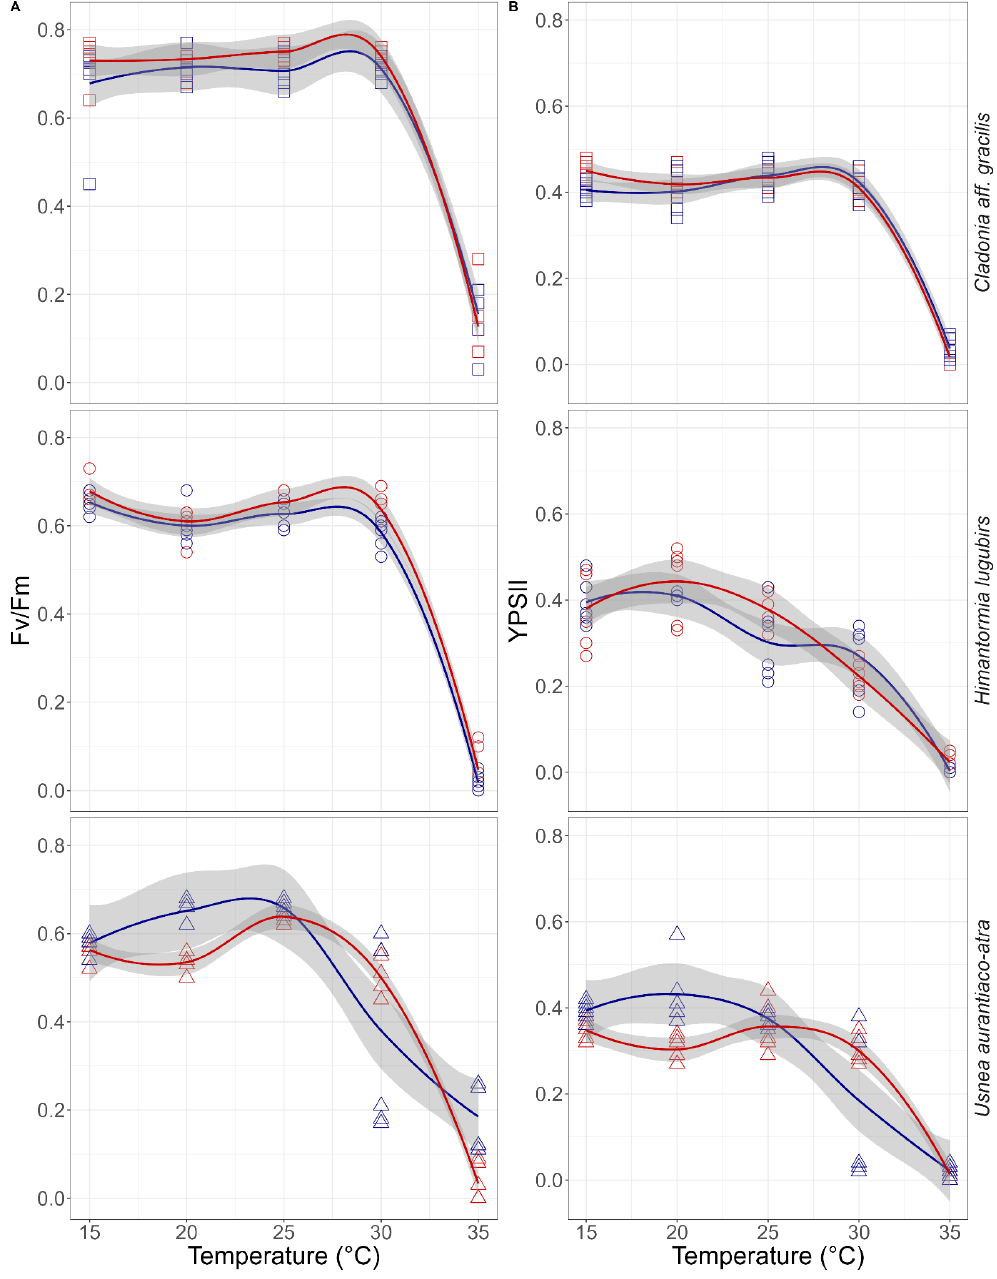
Figure 6. Changes in ( A ) Fv/Fm and ( B ) YPSII upon one-hour thermal shock treatments (for the temperature, see Figure 6 legend) for the Antarctic species Cladonia aff. gracilis (□), Himantormia lugubris ( ○ ), and Usnea aurantiaco-atra ( △ ). Results for samples exposed to passive warming are colored with red and control with blue; tendency lines correspond to local polynomial regression fitting, and gray area indicates the standard error of the tendency lines using t-based approximation.